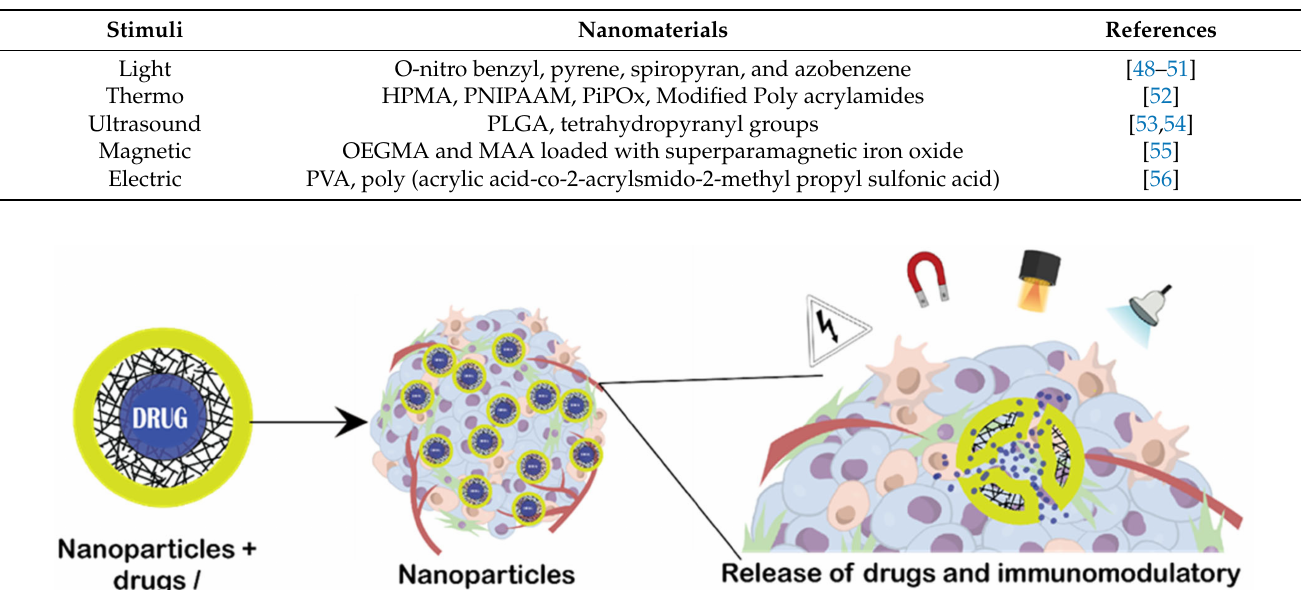
Table 2. Exogenous stimuli responsive polymeric nanoparticles.